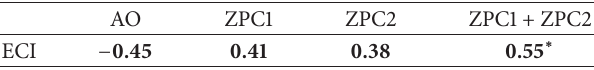
Table 1: Correlation coefficients between all the indices studied. Note that the bold (asterisks) numbers and asterisks indicate